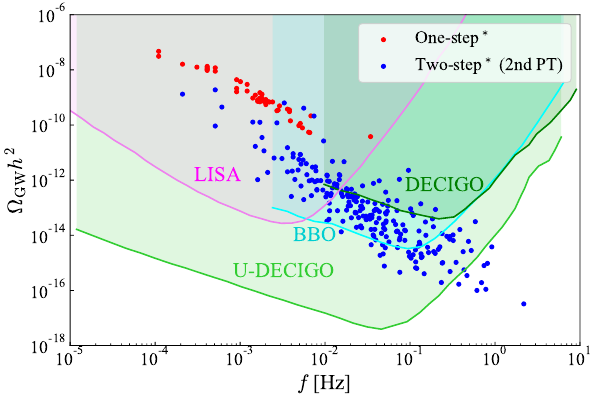
Figure 5 . Peaks of the GW energy density fraction as a function of the frequency for the one-step ∗ PT (red) and the 2nd PT of the two-step ∗ (blue). The colored regions are observable areas by future space-based